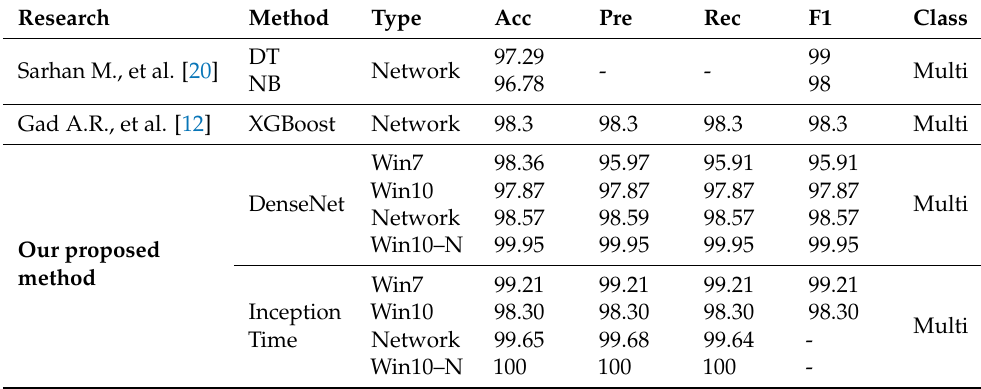
Table 7. Comparison of the results of previous studies using the ToN-IoT